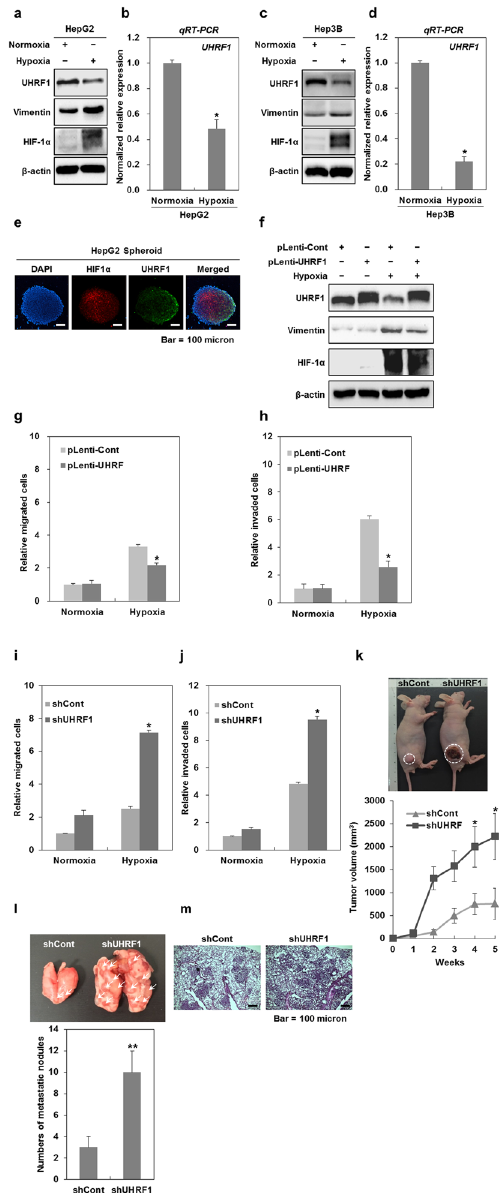
Figure 2. Hypoxia-induced downregulation of UHRF1 contributes to the occurrence of EMT. ( a ) Western blot analysis for UHRF1, vimentin and HIF-1 α in HepG2 cells grown under normoxia and hypoxia for 24 h. ( b ) qRT-PCR analysis for the mRNA expression level of UHRF1 in HepG2 cells grown under normoxia and hypoxia for 24 h. ( c ) Western blot analysis for UHRF1, vimentin and HIF-1 α in Hep3B cells grown under normoxia and hypoxia for 24 h. ( d ) qRT-PCR analysis for the mRNA expression level of UHRF1 in Hep3B cells grown under normoxia and hypoxia for 24 h. ( e ) Immunocytochemistry for HIF-1 α and UHRF1 in a HepG2 spheroid. ( f ) Western blot analysis for UHRF1, vimentin and HIF-1 α in UHRF1-overexpressing HepG2 cells. ( g and h ) Effects of UHRF1 overexpression on the migratory and invasive properties of HepG2 cells grown under hypoxia for 24 h. The migration and invasion assay were performed using the Transwell chamber. ( I and J ) Effects of UHRF1 deficiency on the migratory and invasive properties of HepG2 cells grown under hypoxia for 24 h. The migration and invasion assay were performed using the Transwell chamber. ( k ) Effects of UHRF1 deficiency on tumorigenic capacity of HepG2 cells in vivo . shCont- and shUHRF1-HepG2 cells were subcutaneously injected to the right flank of athymic BALB/c female nude mice (n = 5 per group). After 5 weeks, tumor mass was photographed under a light microscope (up). The average of tumor volumes was measured at 1-week intervals (down). ( l ) Quantification of lung metastasis determined by counting the number of foci on the lung surface after tail vein injection of shCont- and shUHRF1-HepG2 cells (n = 4 per group). ( m ) H&E staining of lung sections after tail vein injection of shCont- and shUHRF1-HepG2 cells. β -actin was used as a loading control. Results from three independent experiments are expressed as means ± SEMs. ( * P < 0.05, ** P <